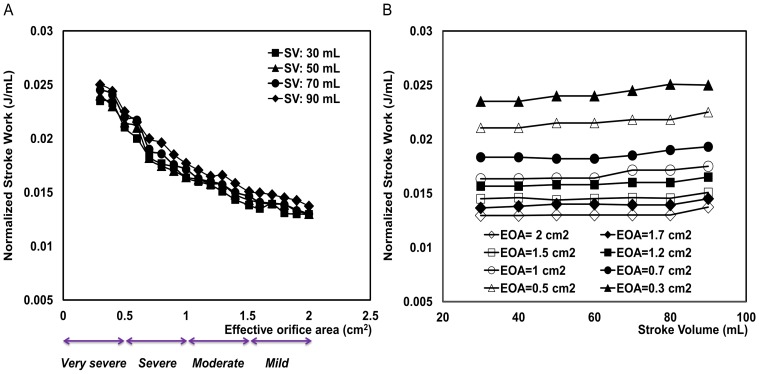
Dependency of normalized left ventricular stroke work to effective orifice area and stroke volume.(a) as a function of effective orifice area (EOA), (b) as a function of stroke volume for normal arterial pressure.